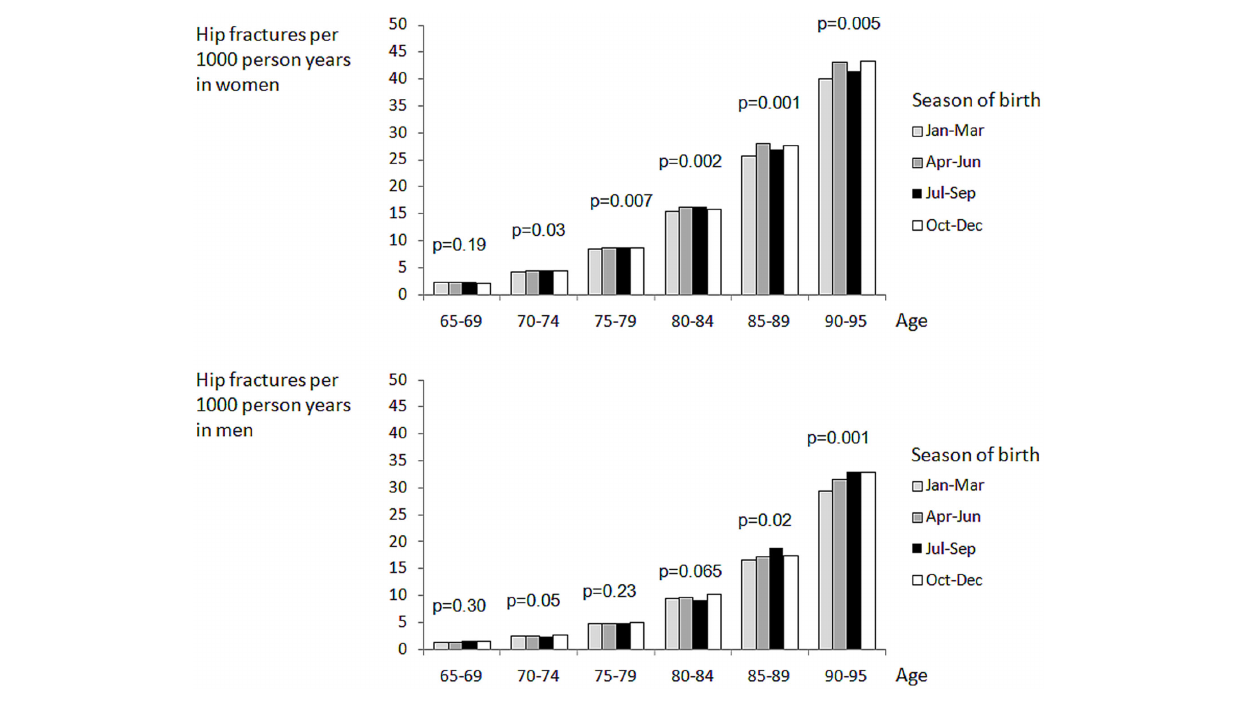
FIGURE 1 | Fractures and season of birth.